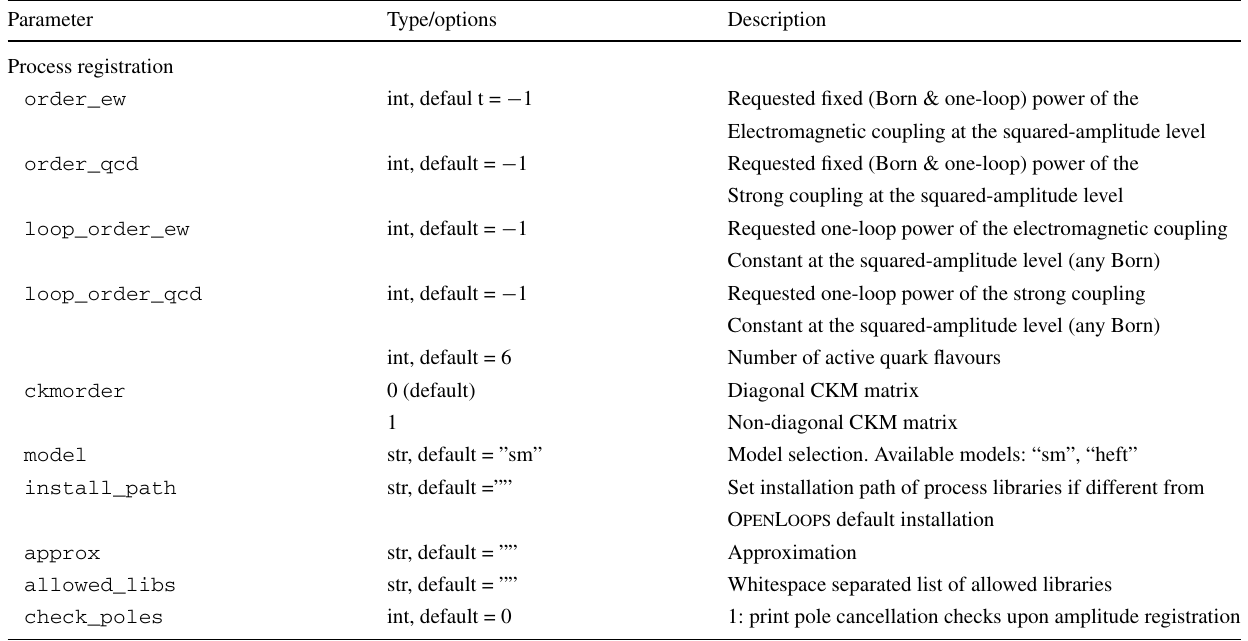
Table 9 Available input parameters and switches in OpenLoops relevant for the process registration. Possible input types include int: integer or str: string. For details see Sect. 4.2